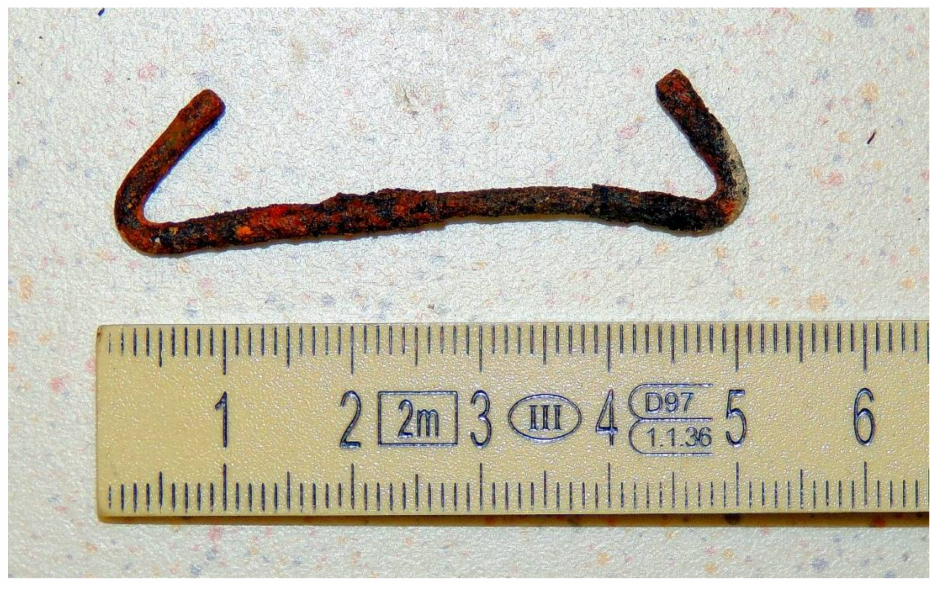
Figure 6. Corroded original binding steel staple.